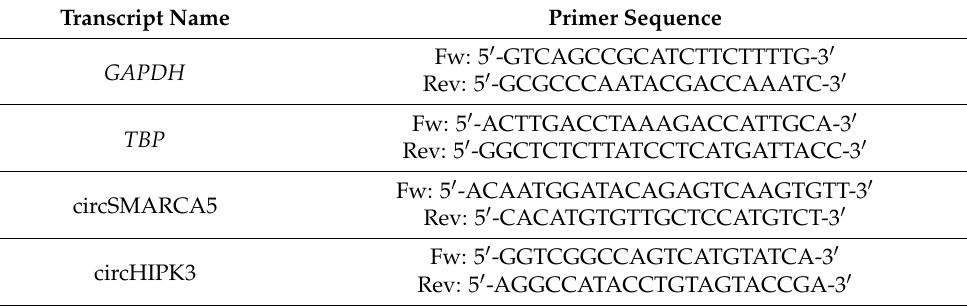
Table 3. Primer sequences used in this